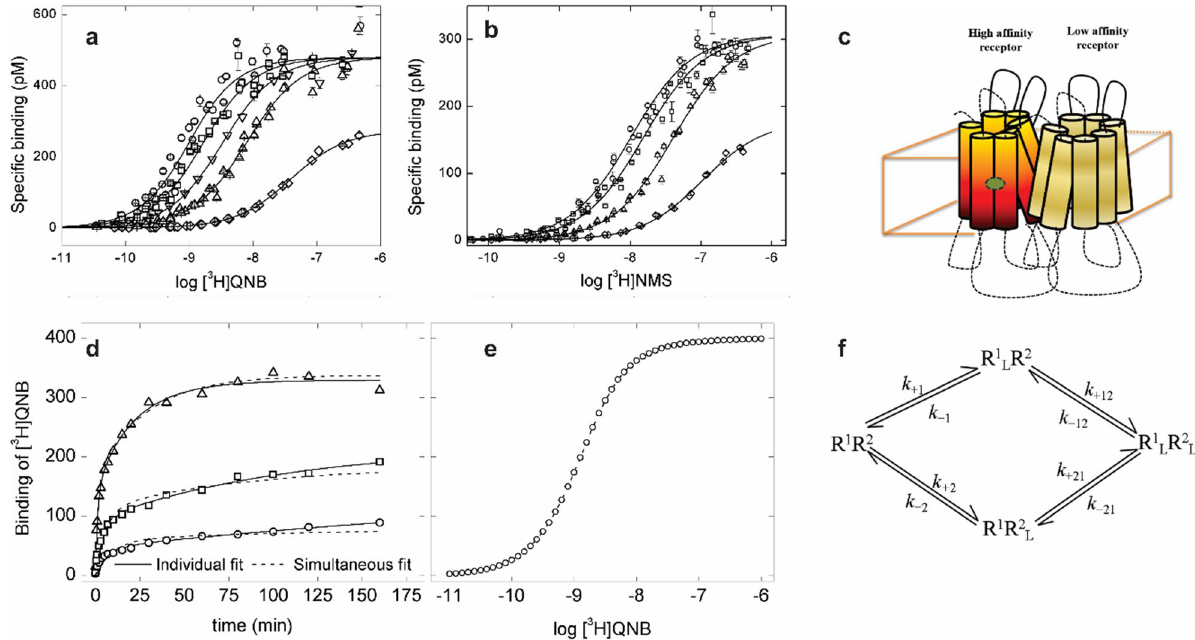
Figure 1. Intermolecular effects in the interaction of orthosteric ligands and tacrine with solubilized M 2 receptor from Sf 9 cells. ( a , b ) Binding at equilibrium. The receptor was mixed with [ 3 H]QNB ( a ) or [ 3 H]NMS ( b ) taken alone (open circle) or together with tacrine at the following concentrations: 10 µM (open square), 100 µM (open upside down triangle), 0.32 mM (open triangle), and 3.2 mM (open rhombus). Binding was measured following equilibration of the samples at 30 °C for 30 h ([ 3 H]QNB) or 15 h ([ 3 H]NMS). The lines depict the best fit of Eq. (2) ( n = 1), and the parametric values are listed in Table S1. ( c ) A graphic depiction of interactions within the dimeric receptor described by Scheme 1. ( d ) Association of [ 3 H]QNB. Receptor was mixed with [ 3 H]QNB (open circle, 0.32 nM; open square, 1.0 nM; open triangle, 5.6 nM), and the mixture was incubated at 30 °C for the times shown on the abscissa. Three experiments were carried out at each concentration of the radioligand. Data represented in the figure were combined with data on the dissociation of [ 3 H]QNB from receptor pretreated with the radioligand at a concentration of 1 nM ( N = 3), and the complete set was analyzed according to Scheme 1. Single values of the rate constants and the co-operativity factor α were common to all of the data. The total concentration of receptor ([R] t ) was measured independently and fixed at 400 pM. Three such analyses included only those data acquired at the same concentration [ 3 H]QNB, and the fitted curves are shown as solid lines; a fourth analysis included all of the data, and the fitted curves are shown as dotted lines. The parametric values from all analyses are listed in Table S2. Further details are described in Figure S2. ( e ) Predicted binding of [ 3 H]QNB at equilibrium. The line was simulated according to Scheme 1, taking the parametric values shown in Table S2 (Analysis 4) and integrating until the system attained equilibrium. An analysis of the simulated curve according to Eq. (2) ( n = 1) gave the following: log K = − 8.91 and n H = 1.01. ( f ) Scheme 1. A dimeric receptor (R 1 R 2 ) binds a ligand (L) at one orthosteric site (R 1 L R 2 , R 1 R 2 L ) or both (R 1 L R 2 L ). Further details are described in “Methods” and Supplementary